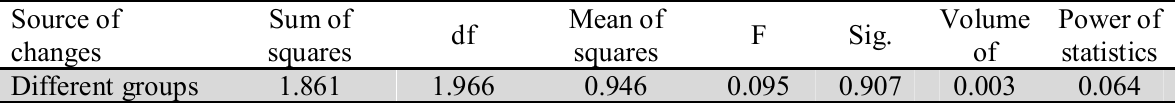
The summary of Greenhouse-Geisser test Source of